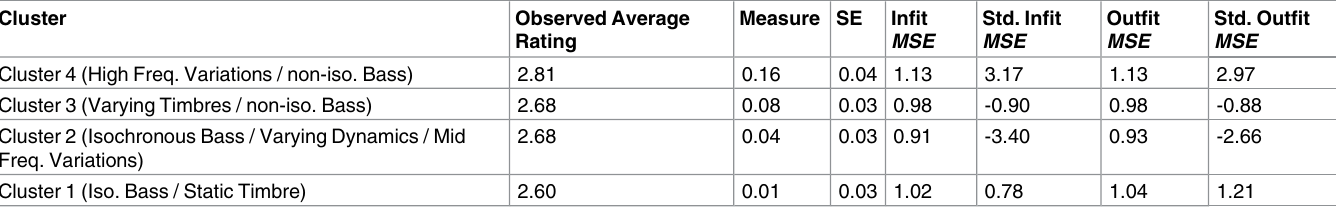
Table 5. Calibration of the Cluster Facet. Spread of the clusters across the logit scale.